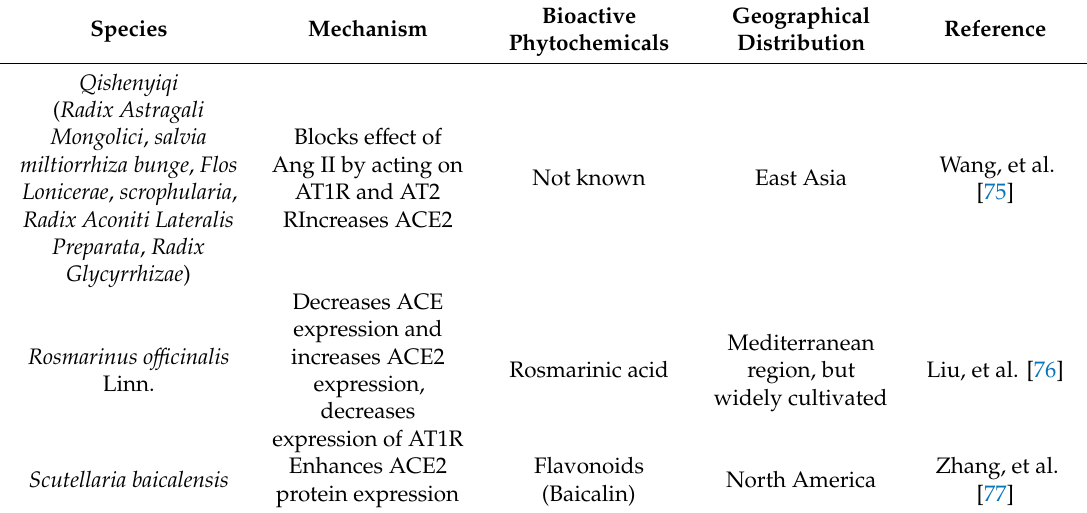
Table 3. Ethno-medicinal plants influencing the ACE2